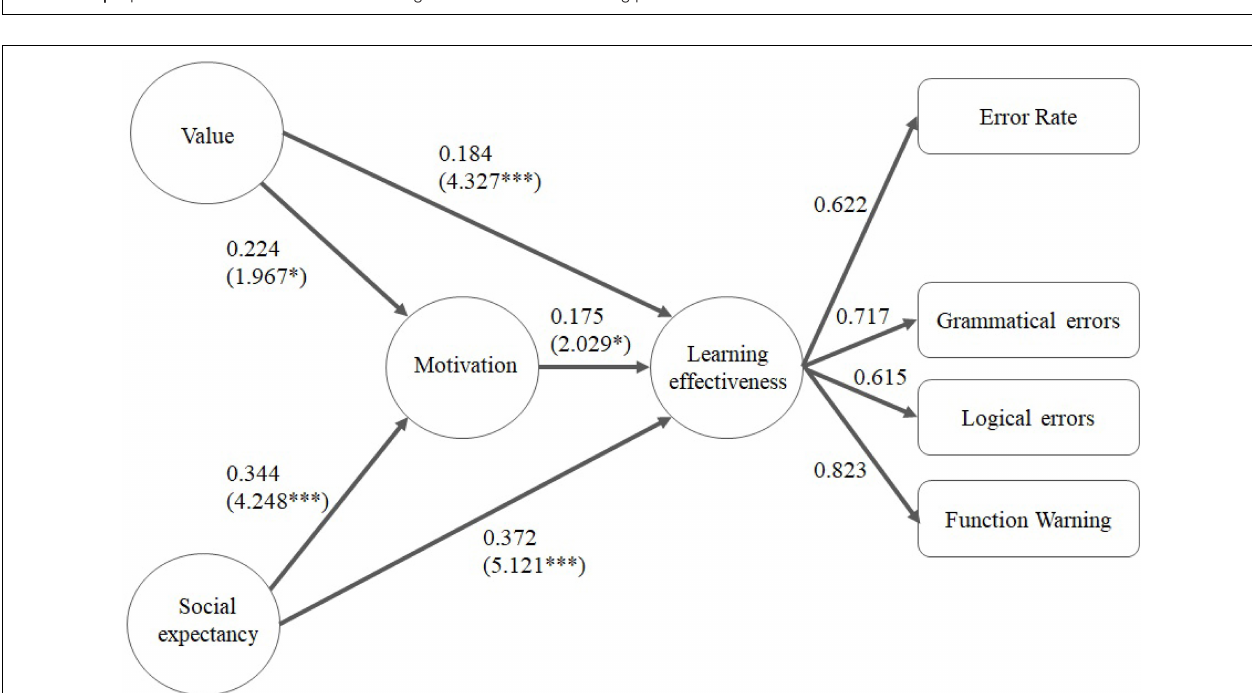
FIGURE 3 | Impact of Han Chinese students’ learning motivation on their learning performance.